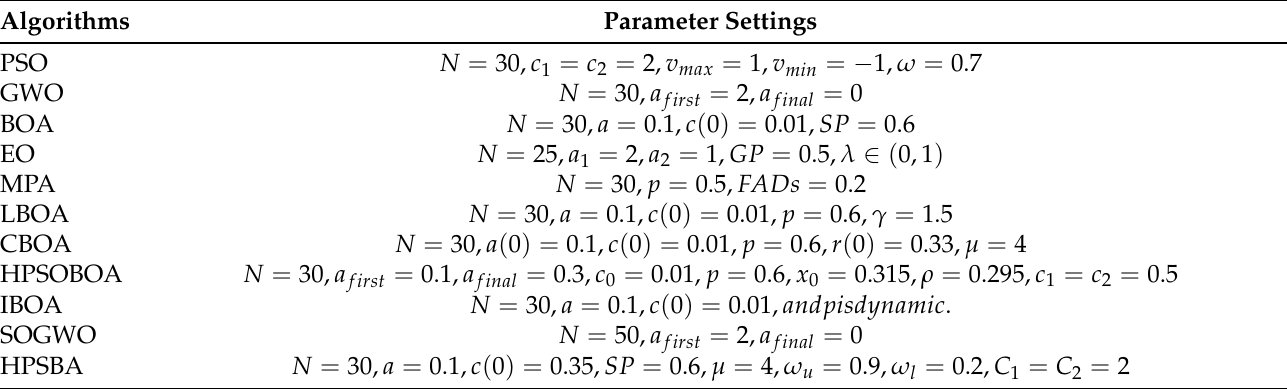
Table 3. Parameter settings of the comparison